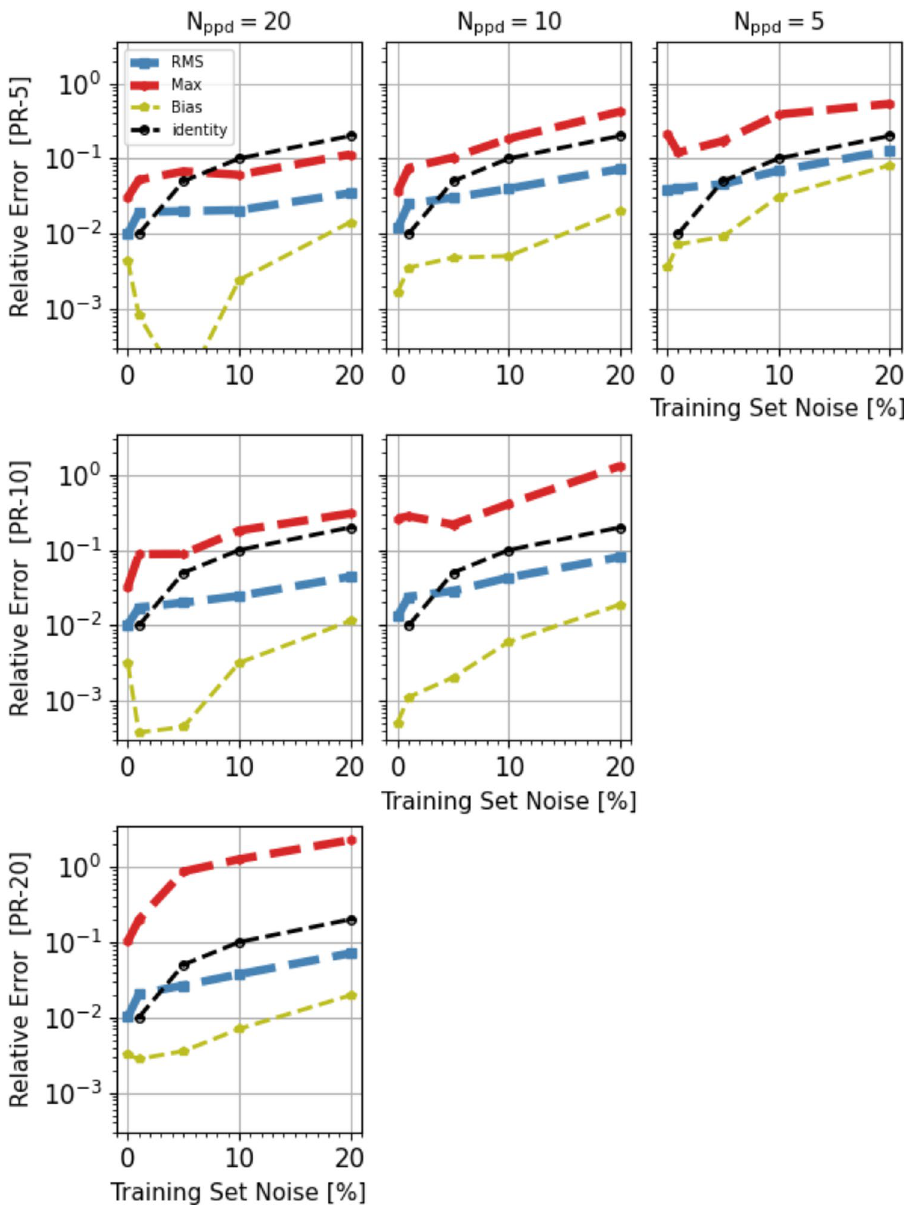
Figure 7. Test-error Statistics: RMS (blue dash line), Max (red dash line) and Bias (yellow thin dash line) statistics of the model prediction errors and their trend with the pre-regularization noise for different sampling size cases. In particular, from top to bottom, the rows correspond to errors computed using the noiseless testset of the C-, B- and A-Series respectively, while from left to right the columns correspond to models trained with 20, 10 and 5, respectively. The half-filled points threaded by the black dash line correspond datasets with N ppd = to the case of equal relative error and input noise (the identity line, which would be diagonal in a linear